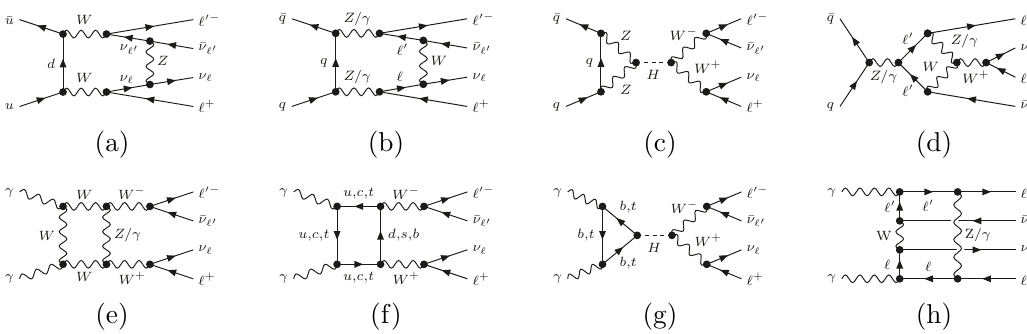
Figure 5 . Sample of one loop diagrams contributing to 2 ‘ 2 (cid:23) production in the di(cid:11)erent-(cid:13)avour case ( ‘ = ‘ 0 ) and in the same-(cid:13)avour case ( ‘ = ‘ 0 ) in the quark-induced (a-d) and photon-induced 6 (e-h) channels.